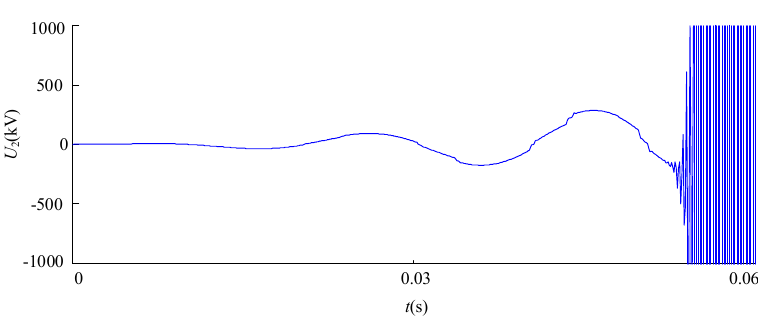
Figure 7. Waveform of the voltage for the original ITM interface model.